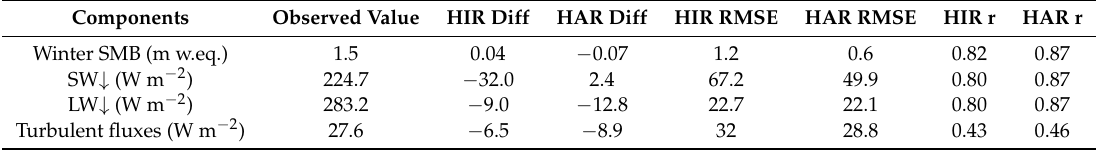
Table 1. Evaluation of the simulated mass balance and energy flux components used to force the snow pack model, i.e., winter mass balance (a measure for precipitation), incoming short- and longwave radiation and turbulent fluxes, in HIRHAM5 and HARMONIE. The mean values of the average difference (model-observations), RMSE, and correlation (r) are given. The turbulent fluxes are a model-model